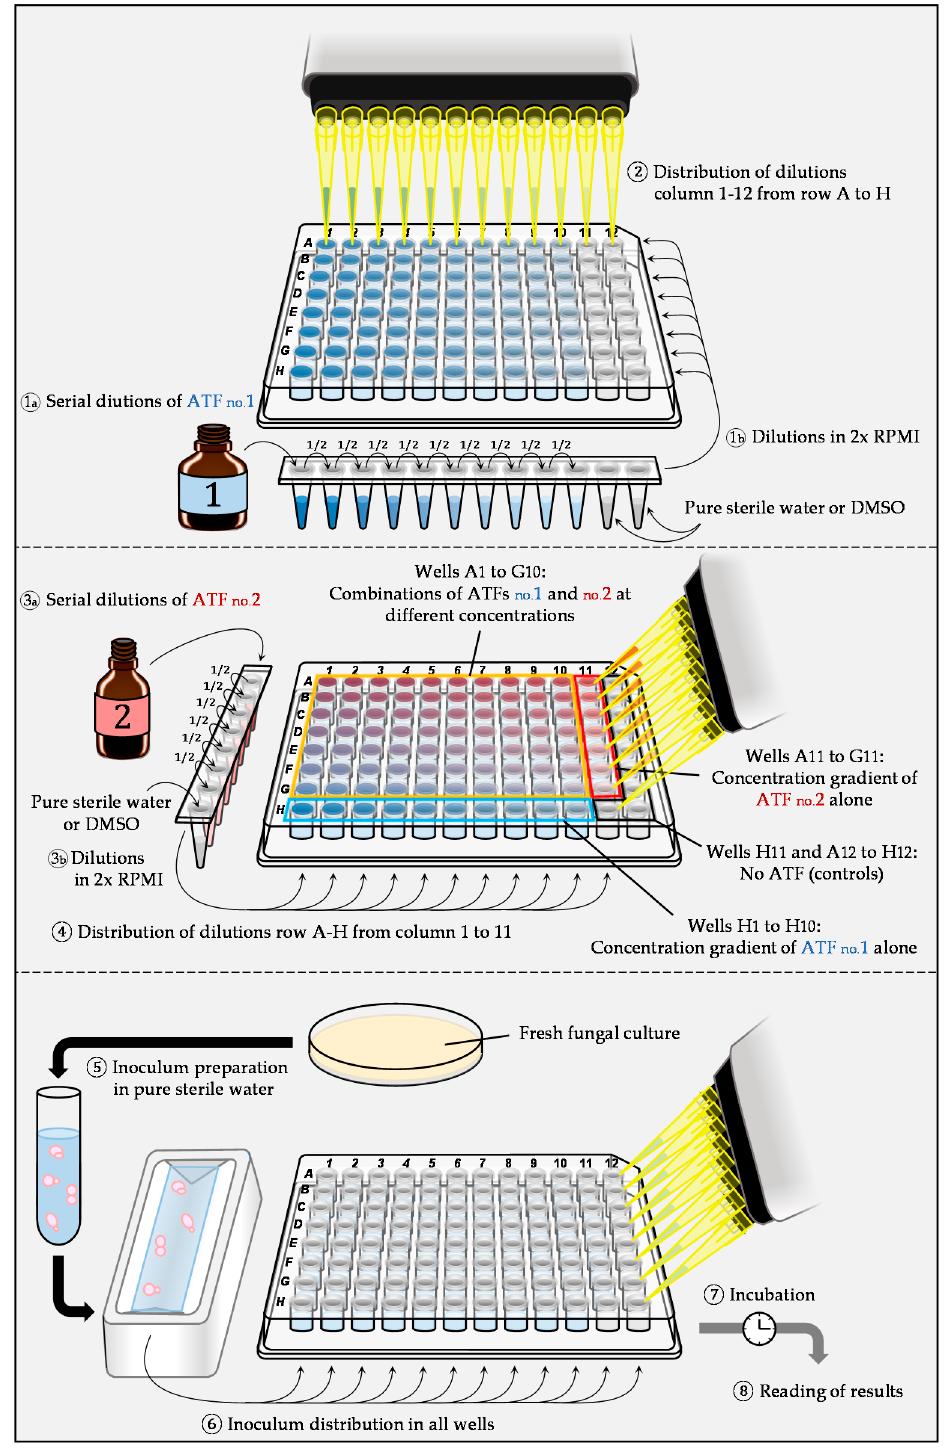
Figure 2. Example of preparation and inoculation of microplates using the checkerboard method based on the EUCAST methodology for antifungal susceptibility testing.